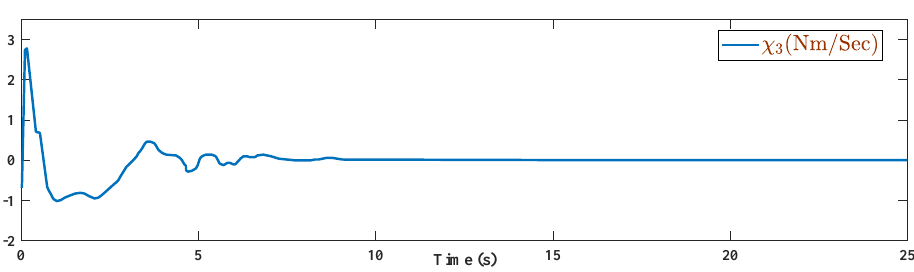
Figure 15. Time response of x 2 related to Scenario 2.